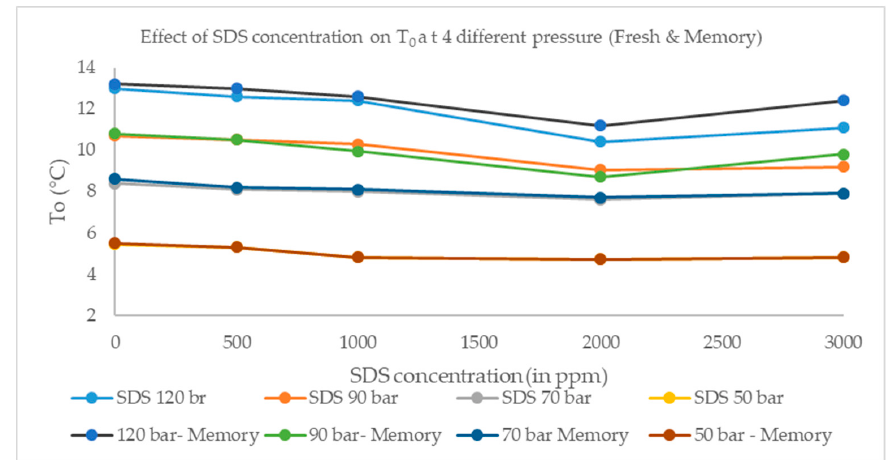
Figure 7. Effect of SDS concentration on T o at different pressures both for fresh and memory run. Figure 7. E ff ect of SDS concentration on T